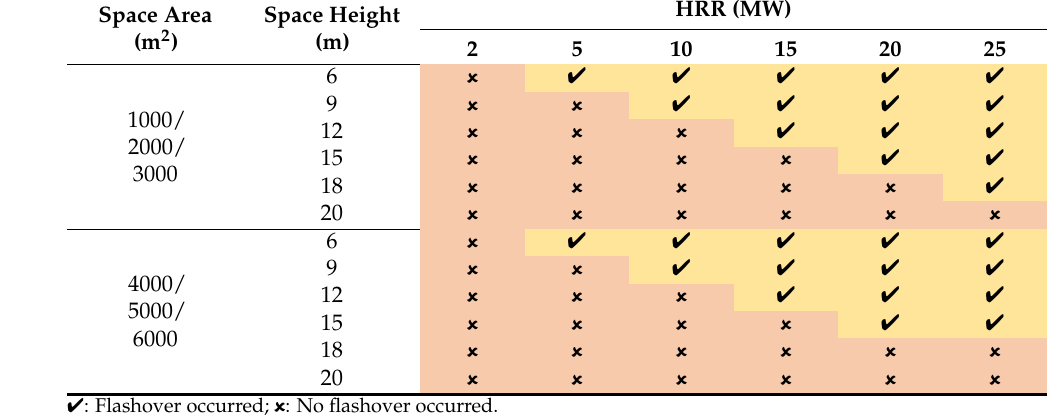
Figure 12. Pectin-PEGMA solution turned white after the addition of α -CD: ( a ) original 10% P-10K solution; and ( b ) 10% P-10K solution after the addition of α -CD (10%).